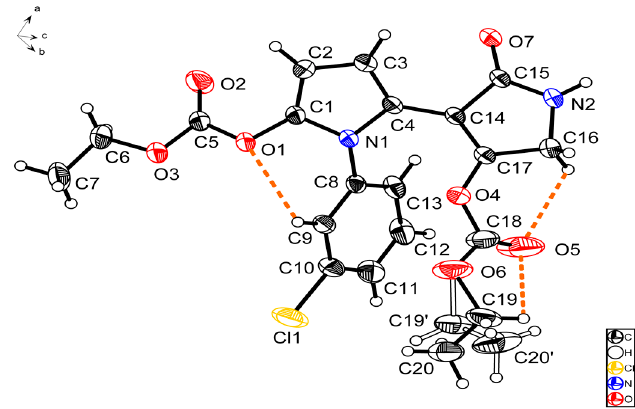
Figure 1. ORTEP diagram of compound 6b with intramolecular hydrogen bonds.